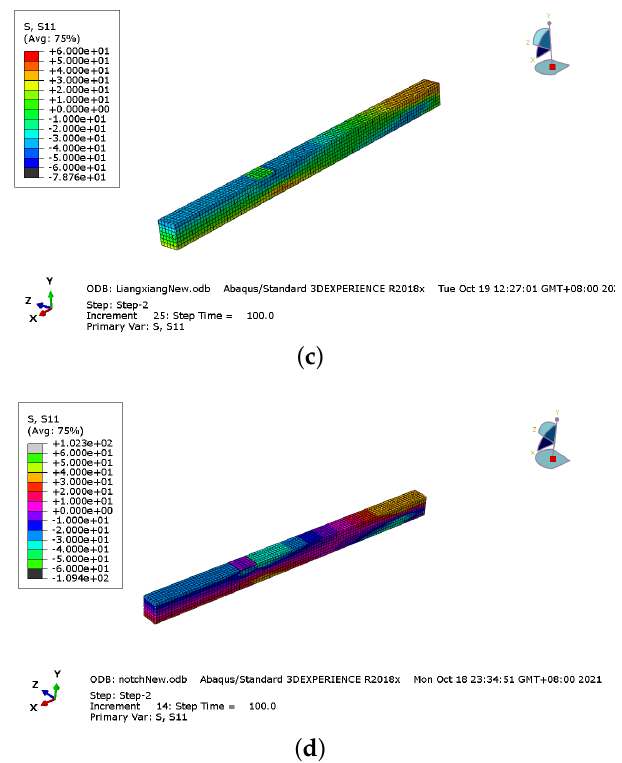
Figure 11. Bending stress distributions of Glulam beams with 30 kN load. ( a ) mode I: external anchorage device, ( b ) mode II: boot anchorage device, ( c ) mode III: under beam anchorage device and ( d ) mode IV: slotted anchorage